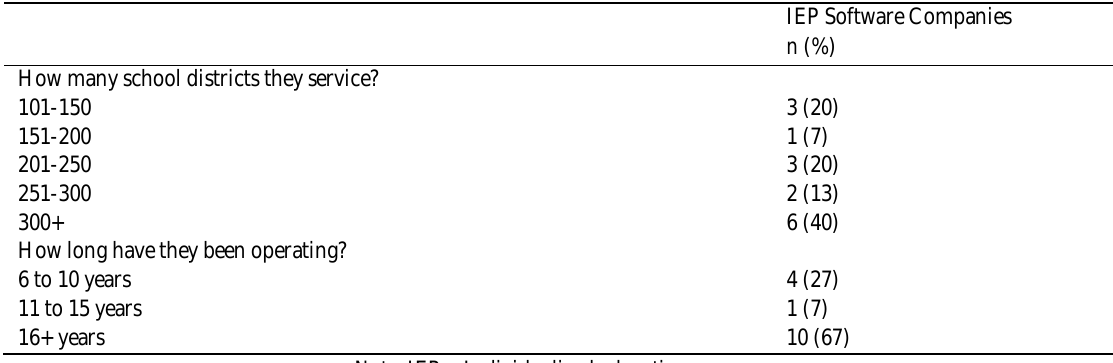
Table 3. Software company